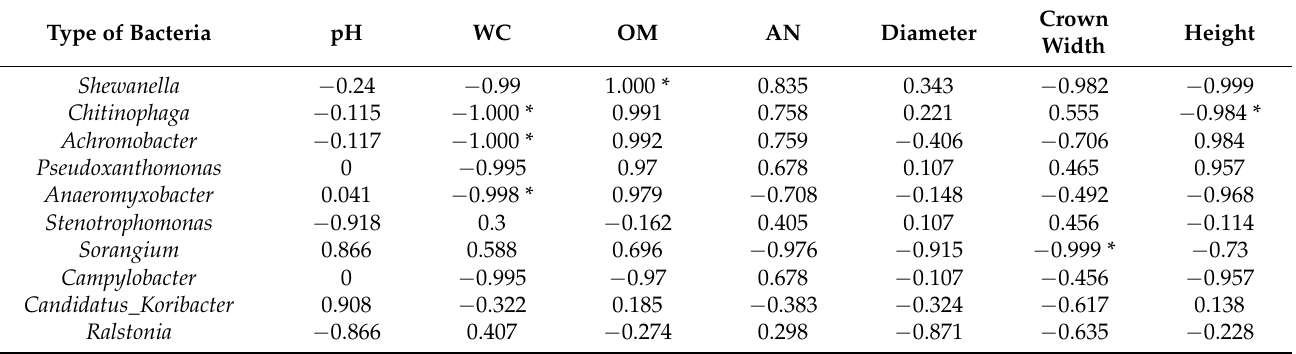
Table 4. The relationships of denitrifying bacteria with plant and soil properties based on Spearman rank correlation